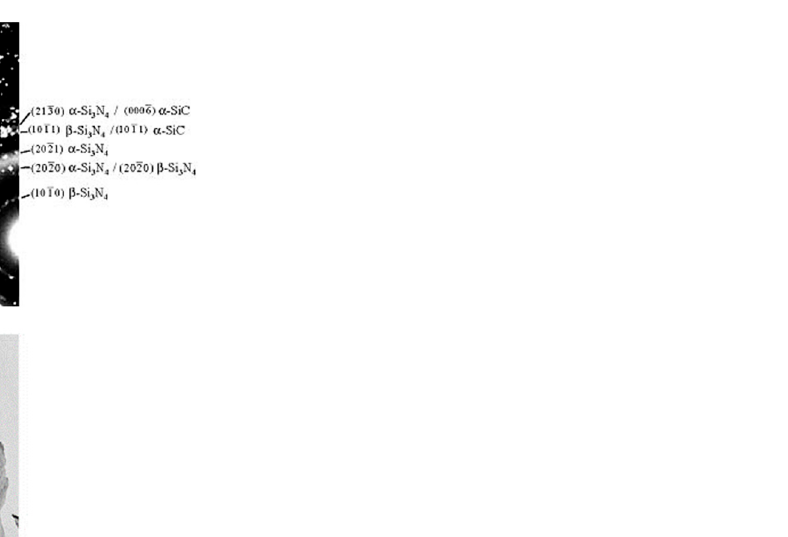
Figure 7. Experimental results for polymer-derived multi-phase nano ceramic: ( a ) selected-area electron diffraction pattern after annealing at 1800 °C; ( b ) bright-field image [91].